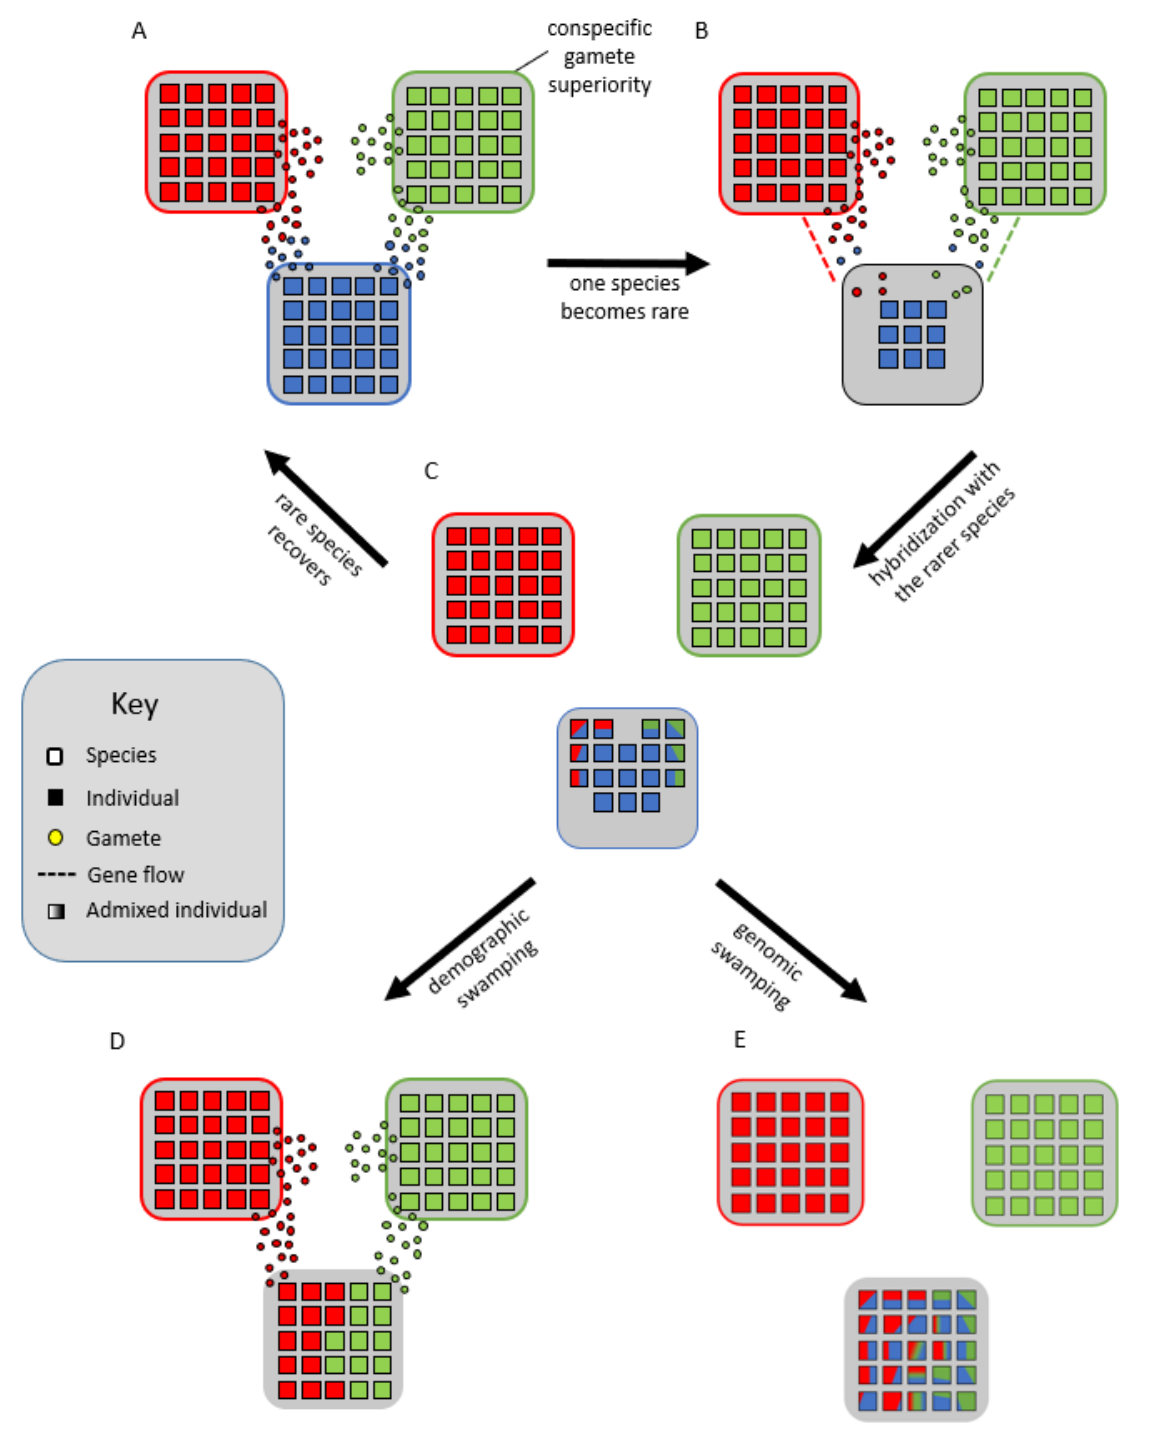
Figure 4. Genomic mutualist hypothesis in which there is a reproductive barrier favoring conspe- cific gametes ( A ) until one species becomes rare ( B ), wherein the gamete load from interspecific donors forces the rarer species to hybridize ( C ). This could lead to the rarer species benefiting from the increased genetic variation and effective population size, allowing it to overcome inbreeding depression and recover, a process known as genetic rescue ( A ). Alternatively, the rarity could lead to demographic swamping, where the rare species is replaced by the more abundant species through the purging of maladaptive hybrids ( D ), or genetic swamping, in which the rare species is replaced by admixed individuals ( E ).